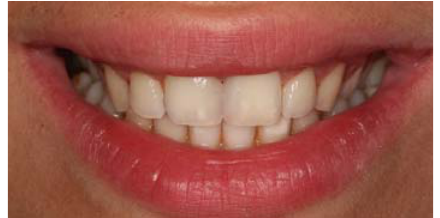
Figure 9: The view of the restorations at one-year